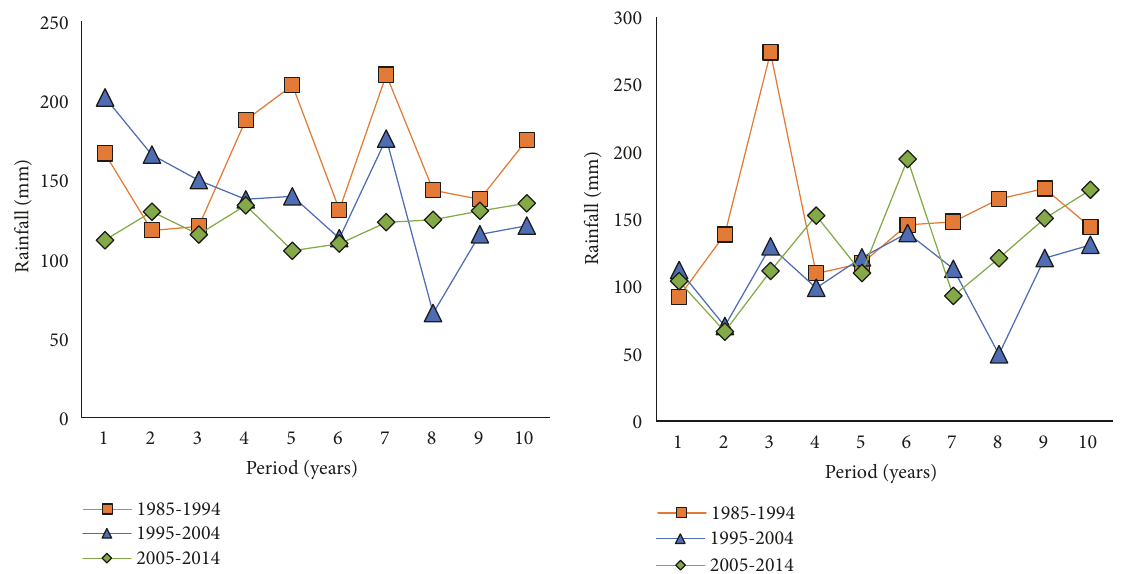
Figure 2: Annual average rainfall for major and minor seasons for three separate decades of 1985-1994, 1995-2004, and 2005-2014 within the Fanteakwa District, Ghana. Source: GMet, 2017.